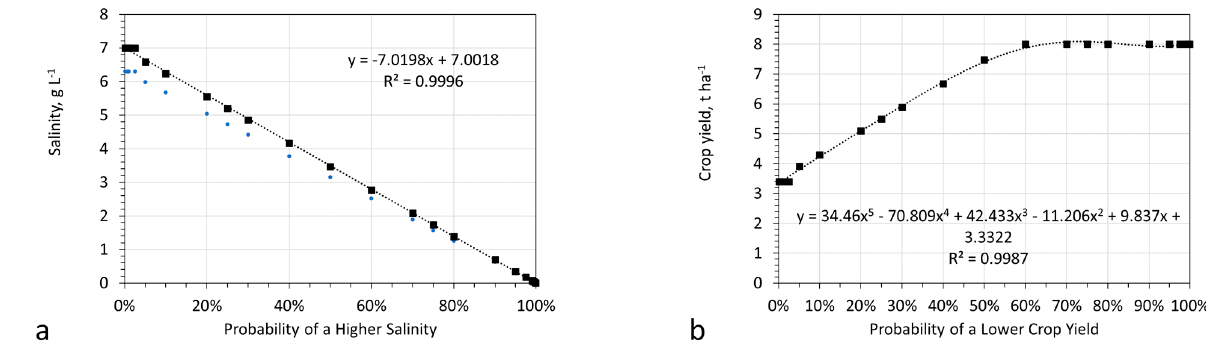
Figure 17. Impact of ZVI desalination on crop yield. ( a ) Probability vs. salinity. Blue circles = irrigation water; black squares = soil salinity; ( b ) expected crop yield probability yield following use of ZVI desalination.